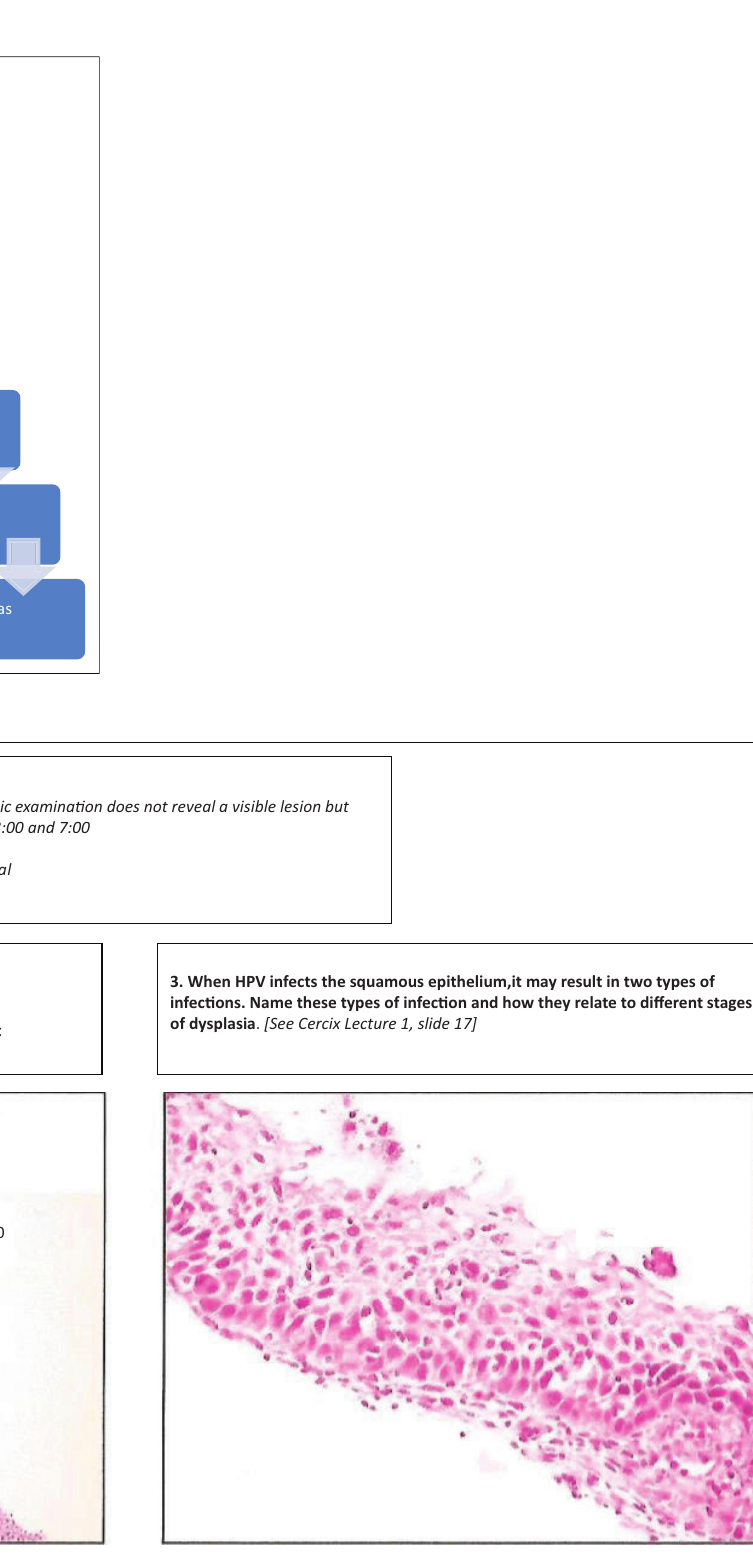
Supplementary Figure 2: Examples of PowerPoint slides printed for pilot testing